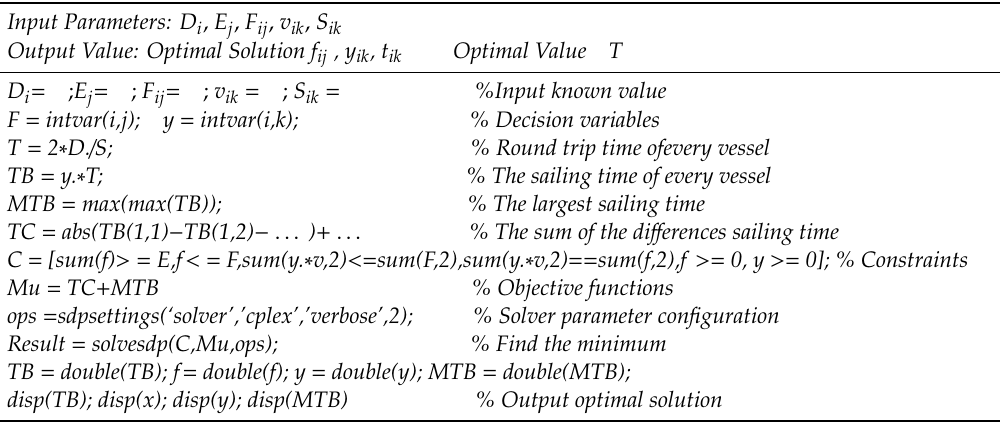
Table 2. The key code of model